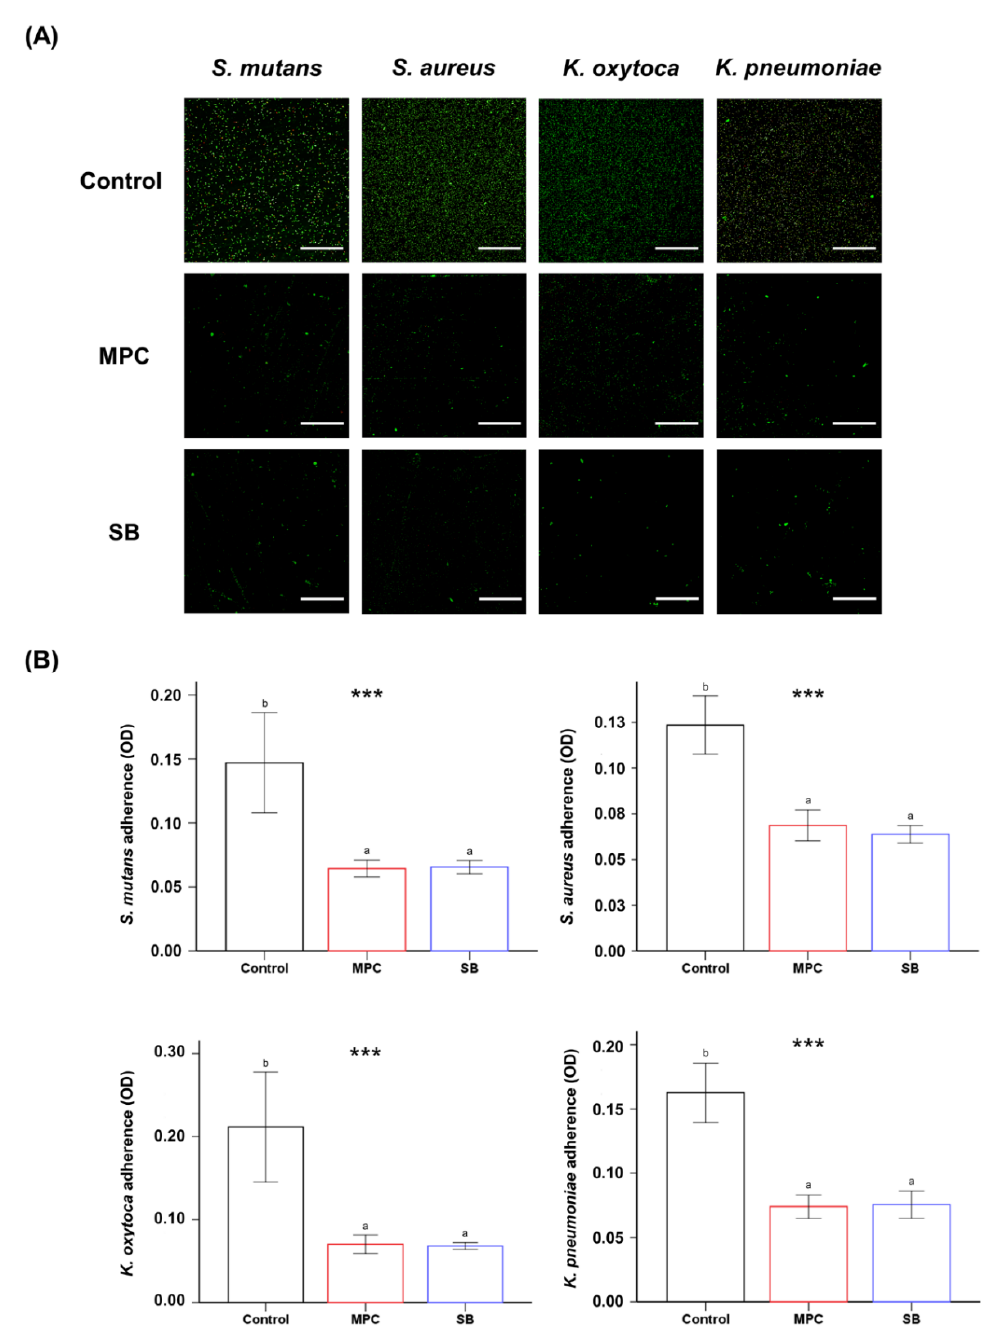
Figure 3. ( A ) Live and dead images of four different bacteria ( S. mutans , S. aureus , K. oxytoca and K. pneumoniae ) attached to poly(methyl methacralyate) (PMMA) before (Control) and after the addition of 2-methacryloyloxyethyl phosphorylcholine (MPC) or sulfobetaine methacrylate (SB). Green coloration indicates live bacteria (scale bar, 100 µm). ( B ) Optical density (OD) readings derived from bacteria attached on the surfaces of the Control, MPC-incorporated PMMA, and SB-incorporated PMMA. Different lowercase letters above the bars indicate significant differences by post-hoc Tukey’s test. *** p < 0.001 for comparisons between PMMA with and without the zwitterion analyzed by one-way analysis of variance (ANOVA).